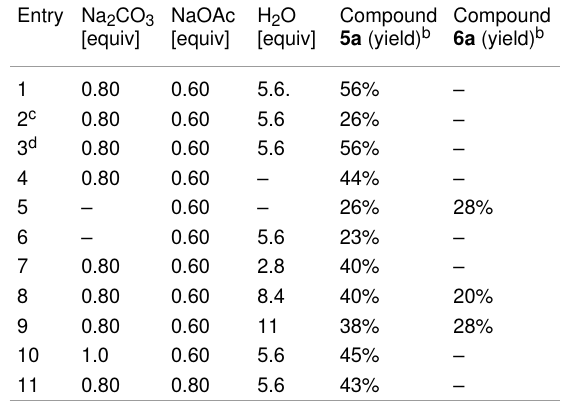
Table 2: Optimization of the formation of 1 H -pyridine 5a or/and α -pyrone 6a in the Michael addition–cyclocondensation reaction with Na 2 CO 3 , NaOAc and water.